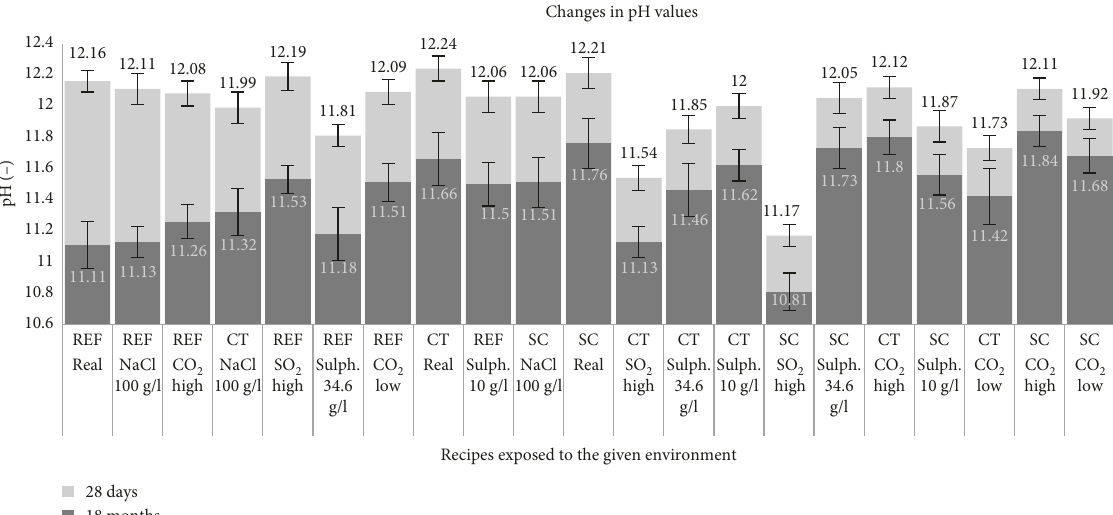
Figure 14: Changes in pH values in leachate for concrete samples before storage in aggressive environment and after 18months in aggressive environment. The error bars represent the range of measurements for 3